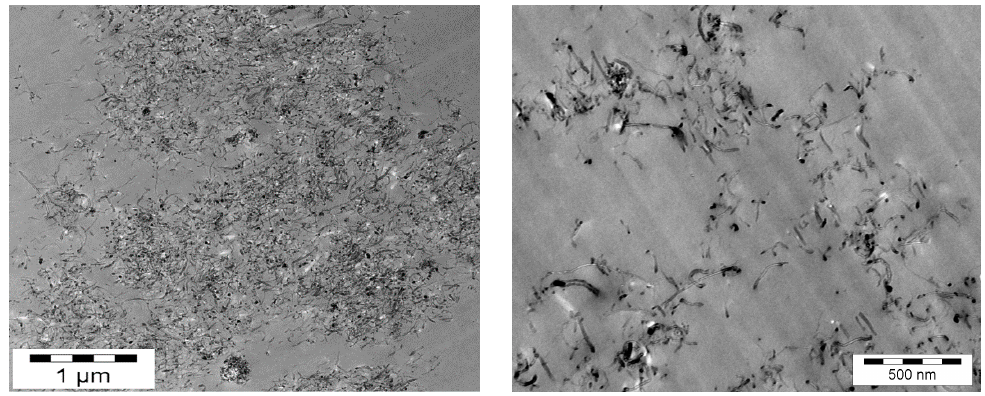
Figure 5. TEM micrographs of epoxy/DDS/MWNT nanocomposites, (0.7 wt %) after a 5 h dispersion with Rayneri ( left ) and after a dispersion with the 3 roll-mill calander ( right ).